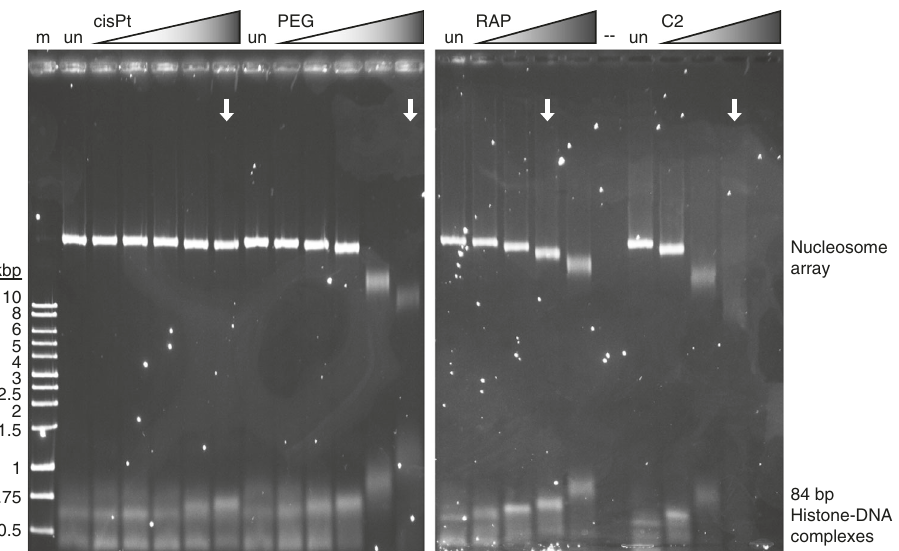
Fig. 6 Electrophoretic mobility shift analysis of drug- and binuclear-treated nuclesosome array. Agarose gel samples include native array (un) and array treated with either cisplatin (cisPt), PEG, RAPTA-C (RAP) or C2 (m, 500 – 10,000 bp DNA marker). Samples corresponding to equimolar high treatment concentration between the four different agents are indicated with arrows. The maximal RAPTA-C and C2 treatments are at fi vefold higher concentration, at which point all of the binuclear-treated material is lost to